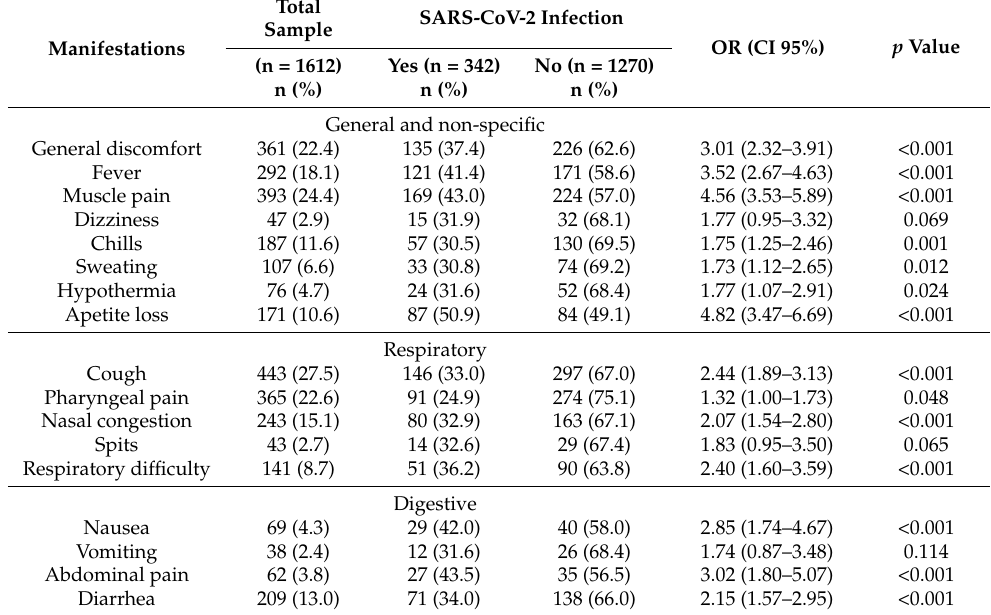
Table 3. Clinical manifestations in study